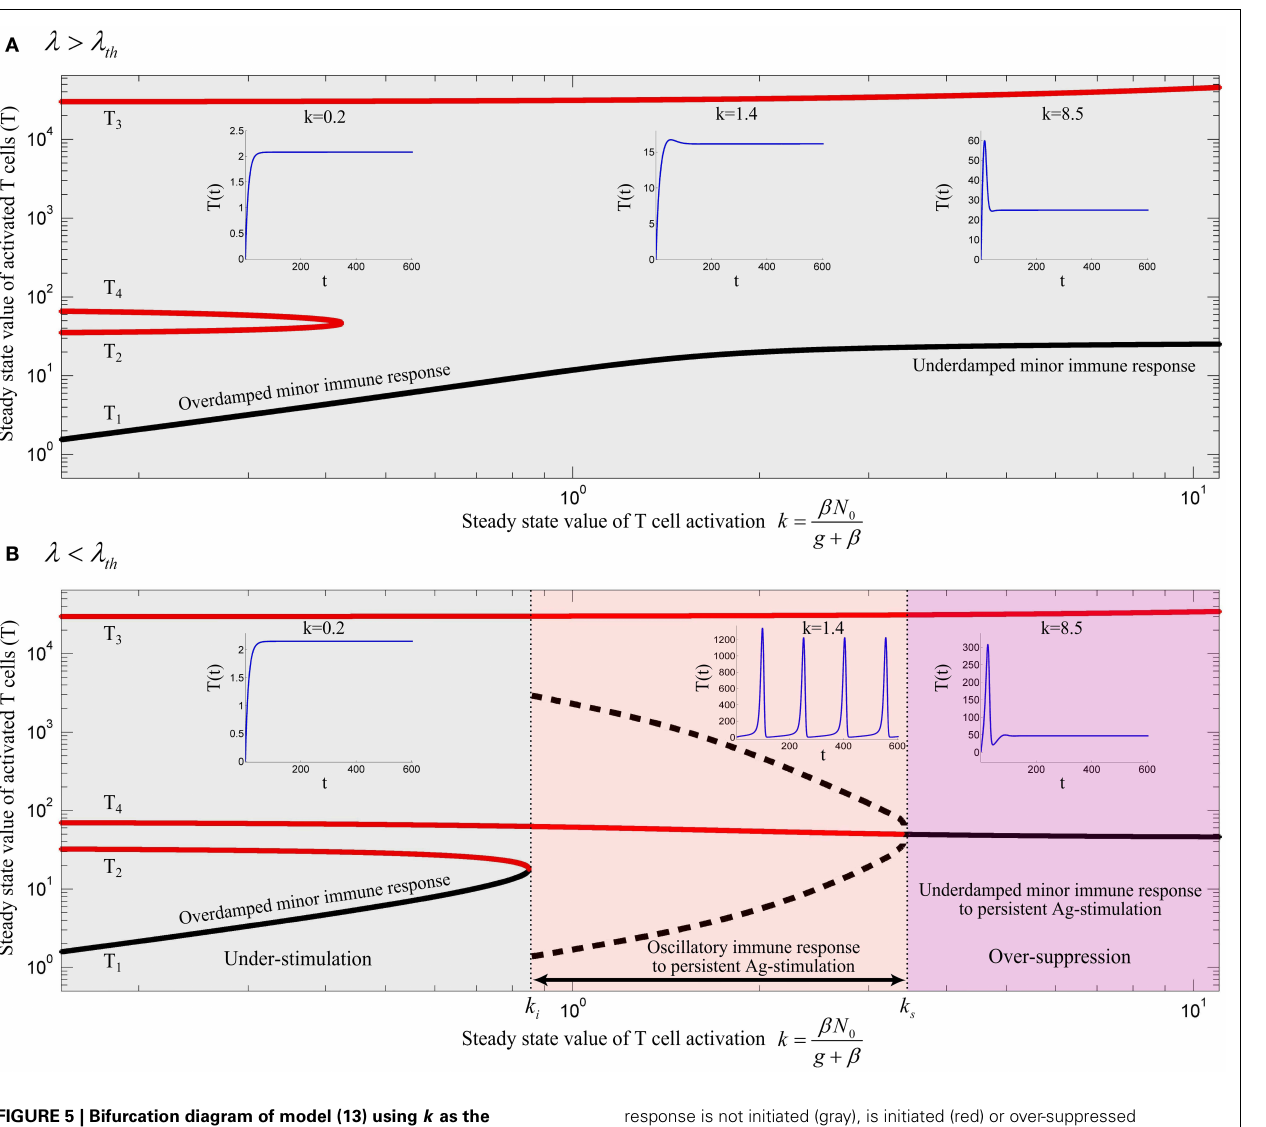
response is not initiated (gray), is initiated (red) or over-suppressed (magenta).With parameter values given in Table 1 , the threshold becomes λ = 0.01183.The time-courses of the activated T cell population T ( t ) were th deduced from a numerical solution of model (13) with zero initial conditions and persistent β .The unstable negative equilibrium point ( T 5 ) is not shown in the plots.